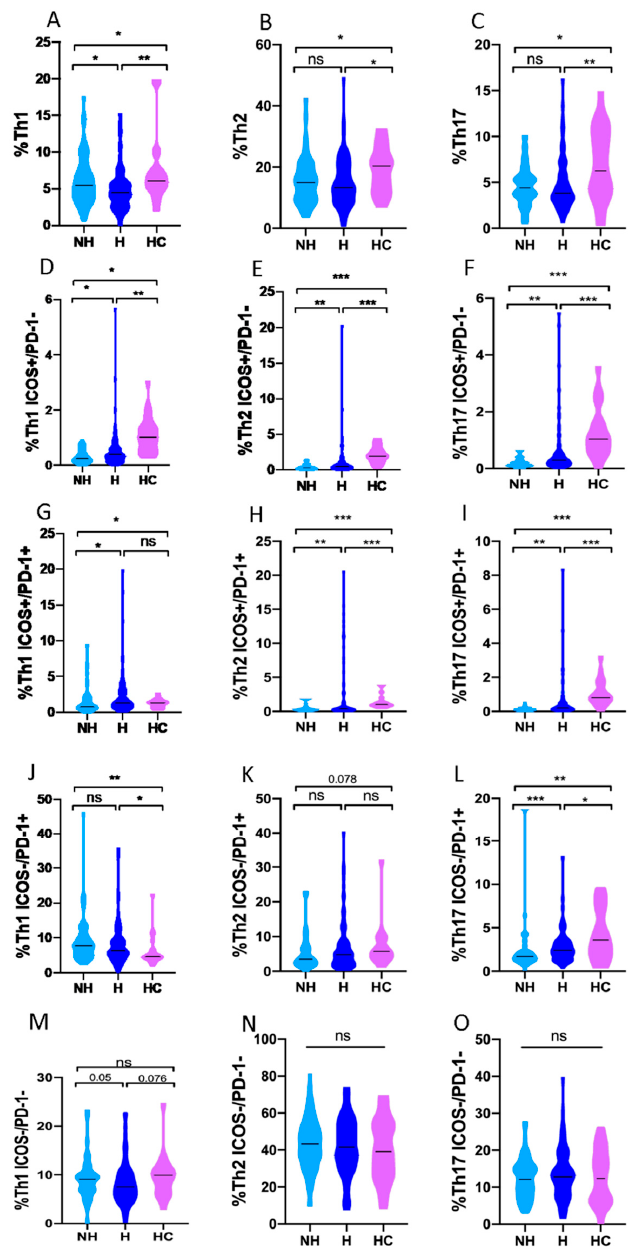
Figure 5. Differences of Th subsets between healthy controls, non-hospitalized and hospitalized COVID-19 patients separately. ( A ) Total percentage of Th1 CD4+ T cells ( B ) Total parentage of Th2 CD4+ T cells ( C ) Total percentage of Th17 CD4+ T cells ( D ) Percentage of early-activated (ICOS+/PD-1-)Th1 CD4+ T cells ( E ) Percentage of early-activated (ICOS+/PD-1-)Th2 CD4+ T cells ( F ) Percentage of early-activated (ICOS+/PD-1-)Th17 CD4+ T cells ( G ) Percentage of late-activated (ICOS+/PD-1+)Th1 CD4+ T cells ( H ) Percentage of late-activated (ICOS+/PD-1+)Th2 CD4+ T cells ( I ) Percentage of late-activated (ICOS+/PD-1+)Th17 CD4+ T cells ( J ) Percentage of senescent (ICOS-/PD- 1+)Th1 CD4+ T cells ( K ) Percentage of senescent (ICOS-/PD-1+)Th2 CD4+ T cells ( L ) Percentage of senescent (ICOS-/PD-1+)Th17 CD4+ T cells ( M ) Percentage of quiescent (ICOS-/PD-1-)Th1 CD4+ T cells ( N ) Percentage of quiescent (ICOS-/PD-1-)Th2 CD4+ T cells ( O ) Percentage of quiescent (ICOS- /PD-1-)Th17 CD4+ T cells. NH; Non-hospitalized COVID-19 patients, H; Hospitalized COVID-19 patients, HC; Healthy controls. ns, not significant; * p < 0.05; ** p < 0.01; *** p <